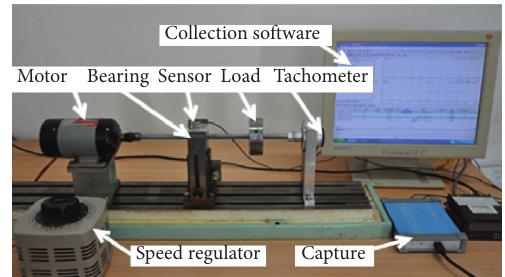
Figure 11: Rolling bearing test bench.